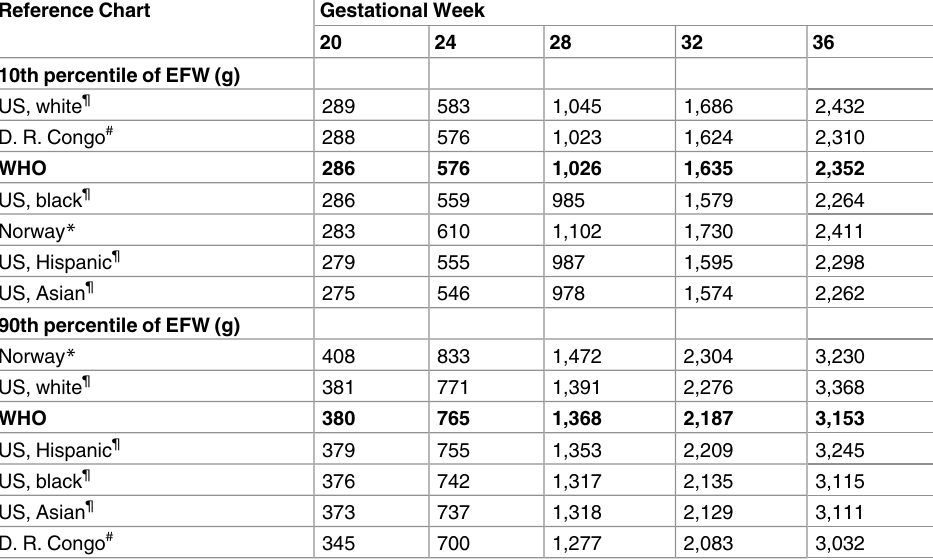
Table 16. The 10th and 90th percentile for estimatedfetal weight in relation to other relevant reference values. Reference